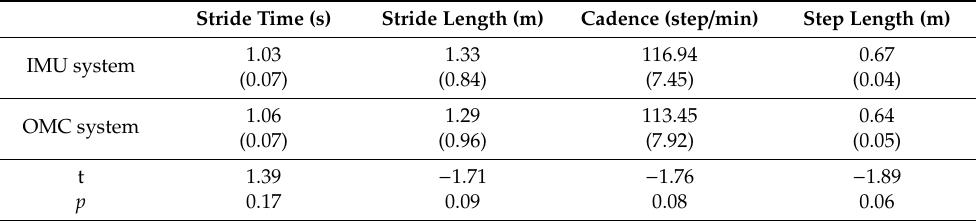
Values represent mean (±standard deviation). IMU: inertial measurement unit system; OMC: optical motion capture. * p < 0.05. Table 3. Kinematic parameters during gait in the IMU system and OMC system. Table 3. Kinematic parameters during gait in the IMU system and OMC system. Knee Joint (Peak to Peak) Ip Joint (Peak to Peak) Left Right